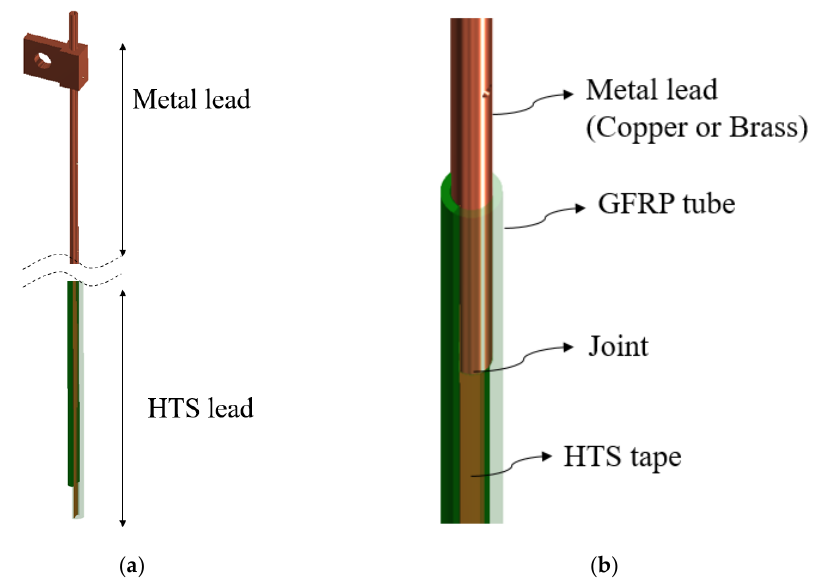
Figure 6. Structure of hybrid current lead. ( a ) Shape of the hybrid current lead; ( b ) Joint between metal current lead and HTS.